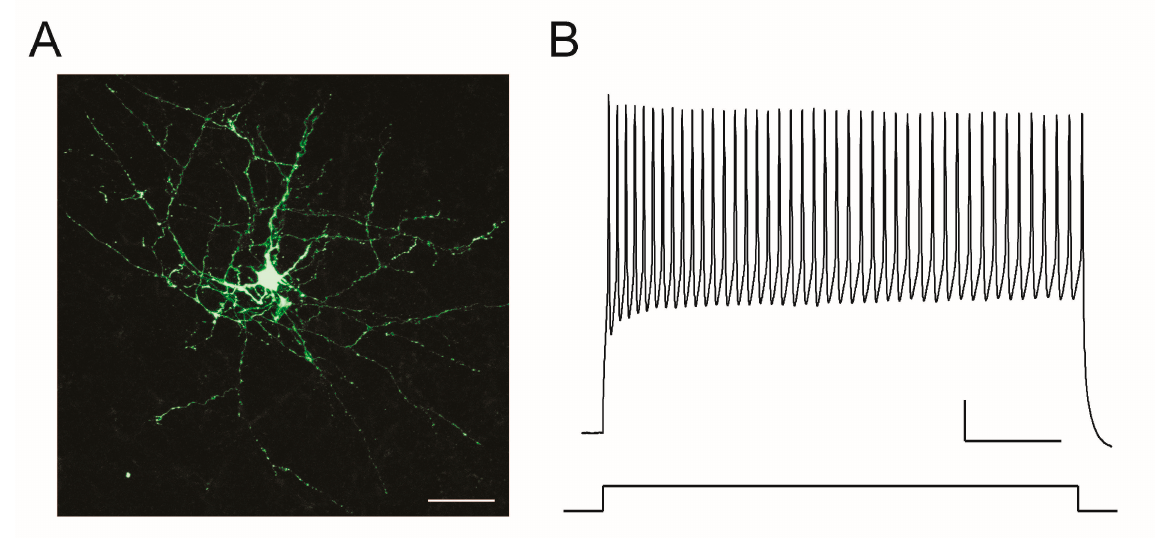
Figure 1. ( A ) PV-positive cortical interneuron filled with biocytin labeled with streptavidin-conjugated AlexaFluor 488. Alterations in this subclass of interneurons are consistently reported in ASD. Scale bar: 50 µ m. ( B ). Typical firing patter of PV interneurons in response to depolarizing current injection (100 pA for 500 ms). These neurons fire action potentials at a high frequency constantly for a prolonged period. The inter-spike intervals do not largely change during the prolonged spike train, i.e., fast-spiking. Calibration: 100 ms and 25 mV (from Reference [81] with edits).